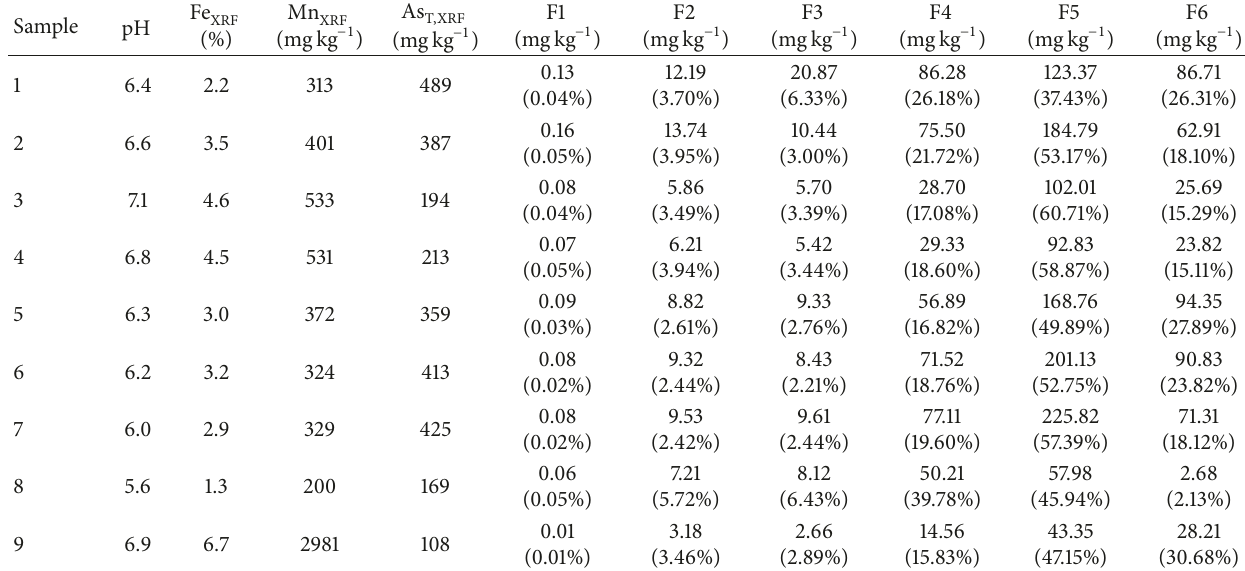
Table 1: Soil pH, pseudo-total Fe, Mn, and As content, and As fractionation in soil samples following the SEP procedure described by Lombi et al.